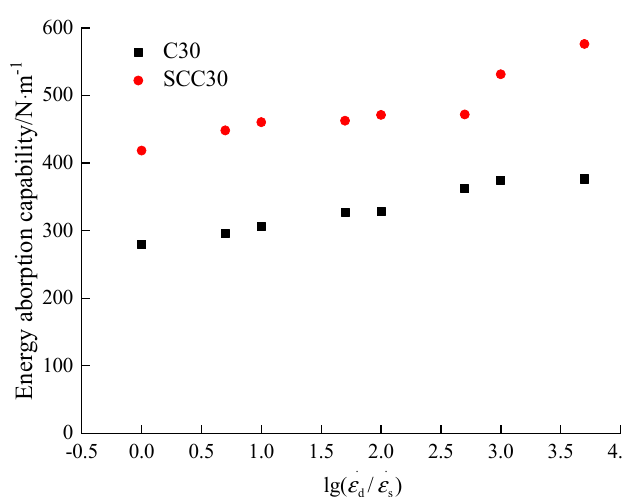
Figure 6. The effect of strain rate on energy absorption capacity.